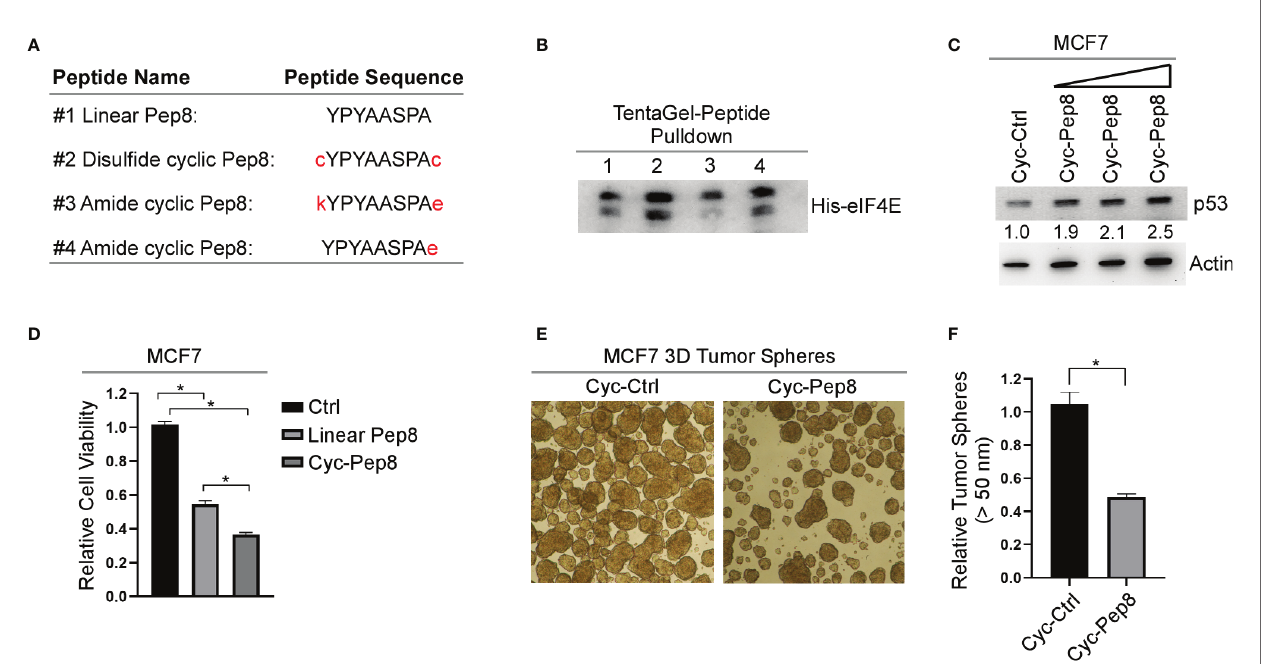
FIGURE 3 | Cyclized Pep8 enhances p53 expression. (A) Sequence of each peptide used and mode of cyclization. (B) Immunoblot for the pull-down of eIF4E with TentaGel-bound peptides. (C) The levels of p53 and actin were measured in MCF7 cells treated with increasing concentrations of Pep-1 delivered disul fi de cyclized Pep8 (50 nM, 150 nM, and 375 nM) for 18 hrs. (D) Relative cell viability was measured in MCF7 2-D cell cultures treated with Pep-1 delivered control, linear-Pep8 or disul fi de cyclic-Pep8 (375 nM) peptide for 24 hrs. Values represent the mean ± SEM of three independent experiments (*, P < 0.05). (E, F) Disul fi de cyclized Pep8 (375 nM) treatment reduces MCF7 tumor sphere formation. Tumor spheres (>50 mm) counted 7 days after peptide treatment. Values represent the mean ± SEM of three independent experiments (*, P <